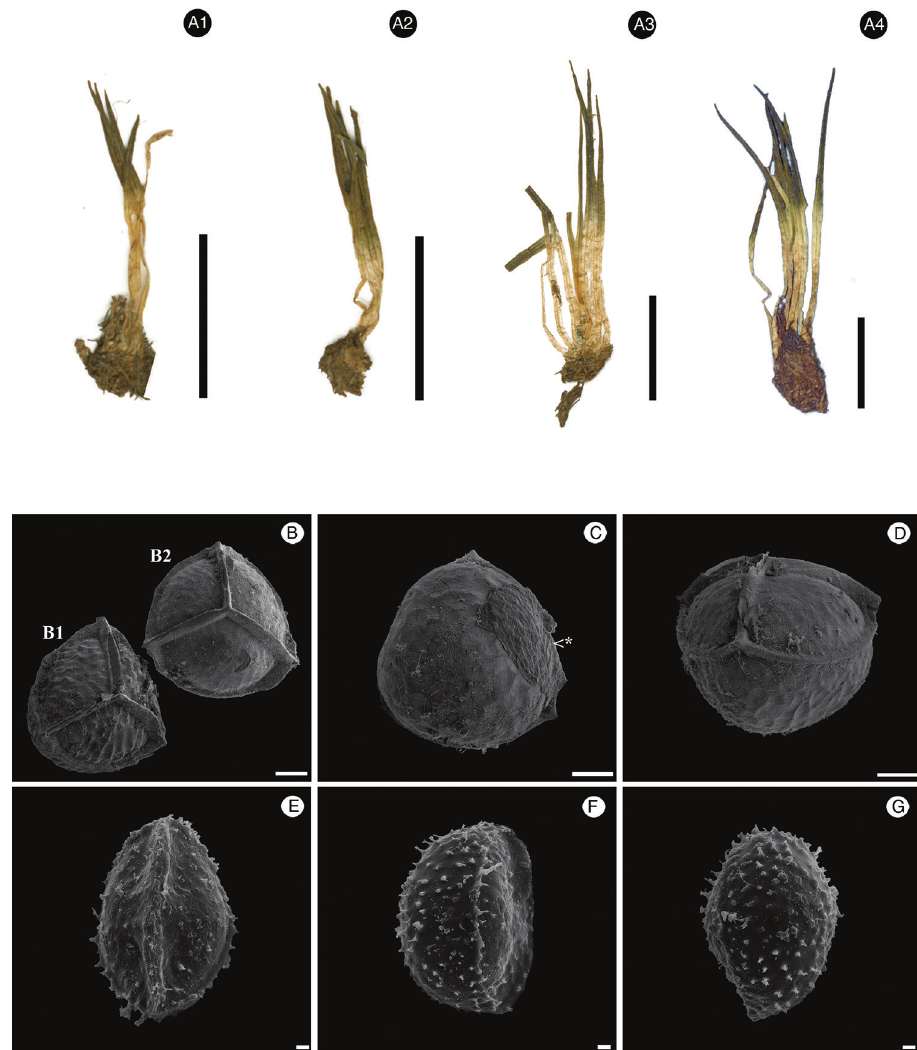
Figure 1. Isoetes nana sp. nov. (from the holotype: Ule 98, G). A1–4 Habit (images are courtesy of the herbarium G) B–D Megaspore B Proximal view of an obscurely cristate (B1) and rugulate (B2) megaspore C Distal view (<*portion of the megaspore covered by sporangium tissue) D Equatorial view E–G Microspore E Proximal view F Equatorial view G Distal view. Scale bars: A1–4 = 1 cm; B–D = 100 µm; E–G = 2